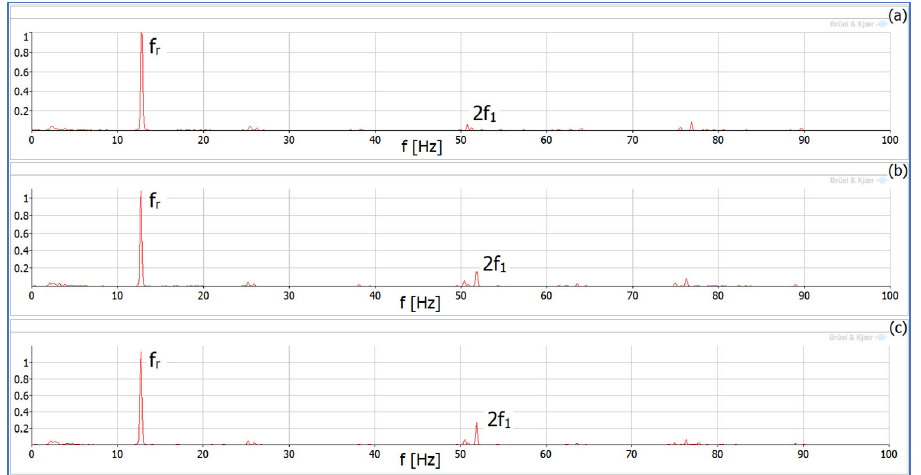
Figure 14. Vibration spectral characteristics for a rotational speed of 750 rpm and under load,